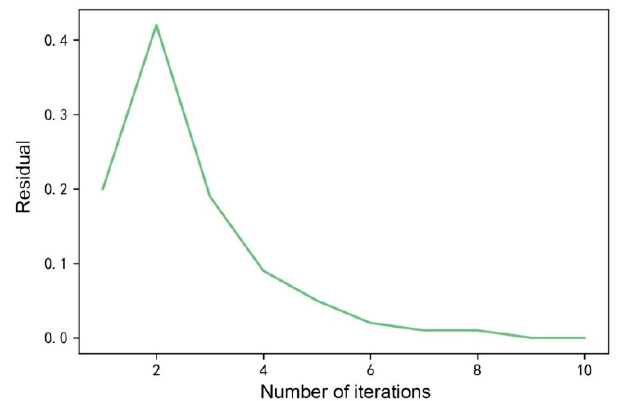
Figure 6. The relation between the residual ( ε ) and the number of iterations.